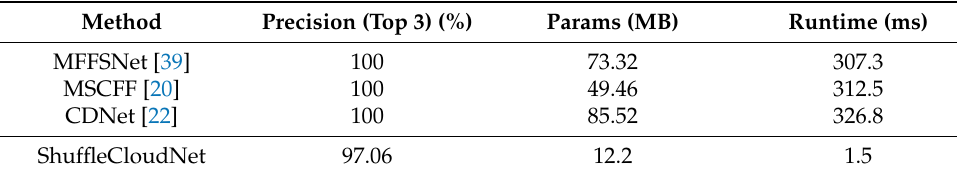
Table 7. Comparison of the parameters and the inference runtime of different methods of cloud